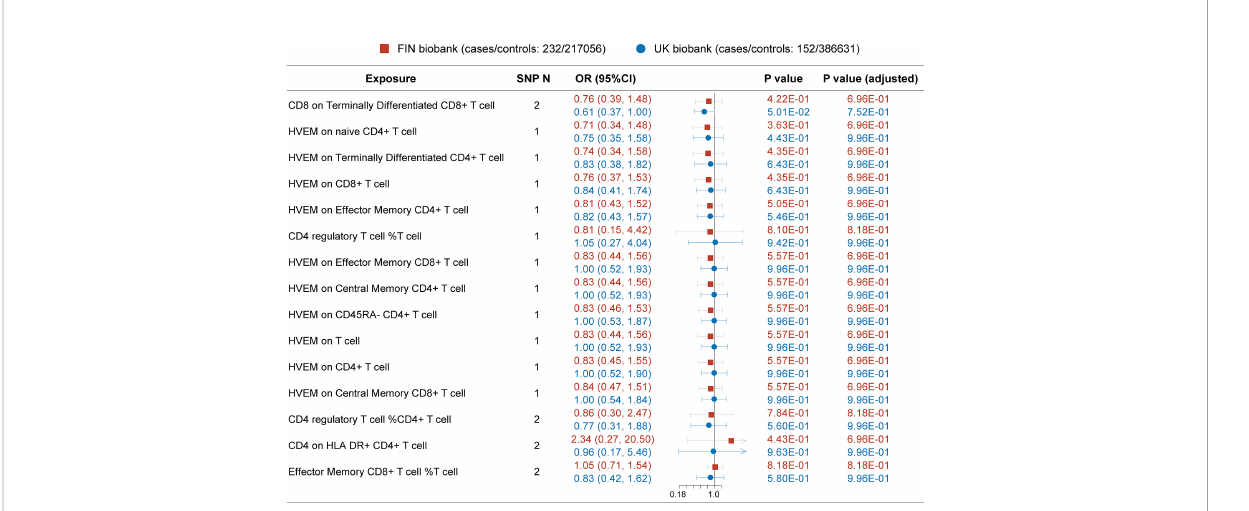
FIGURE 3 MR result in secondary analysis (FIN and UK Biobanks). Before P value adjustment, only the fi rst ranked exposure “ CD8 on terminally differentiated CD8 + T cell ” barely showed signi fi cance in the UK biobank dataset. However, after FDR adjustment, no exposures reach signi fi cance, but the tendencies of which are basically in accordance with the primary analysis (as protective factors). This can be explained by the low powers in all analysis due to paucity in